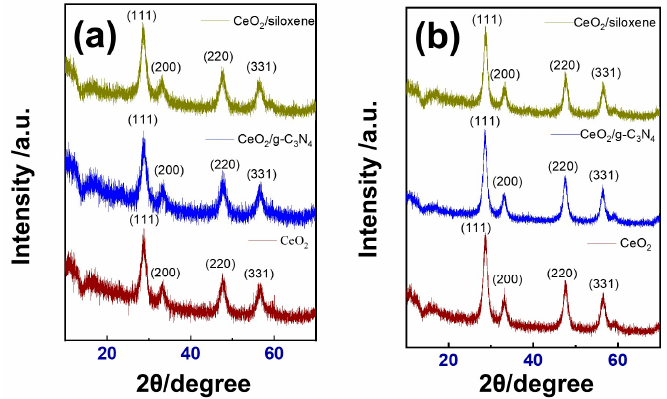
Figure 1. X-ray diffraction pattern of ( a ) cerium oxide (CeO 2 ) and composites pyrolyzed at 350 °C, and ( b ) CeO 2 and composites pyrolyzed at 450 °C .